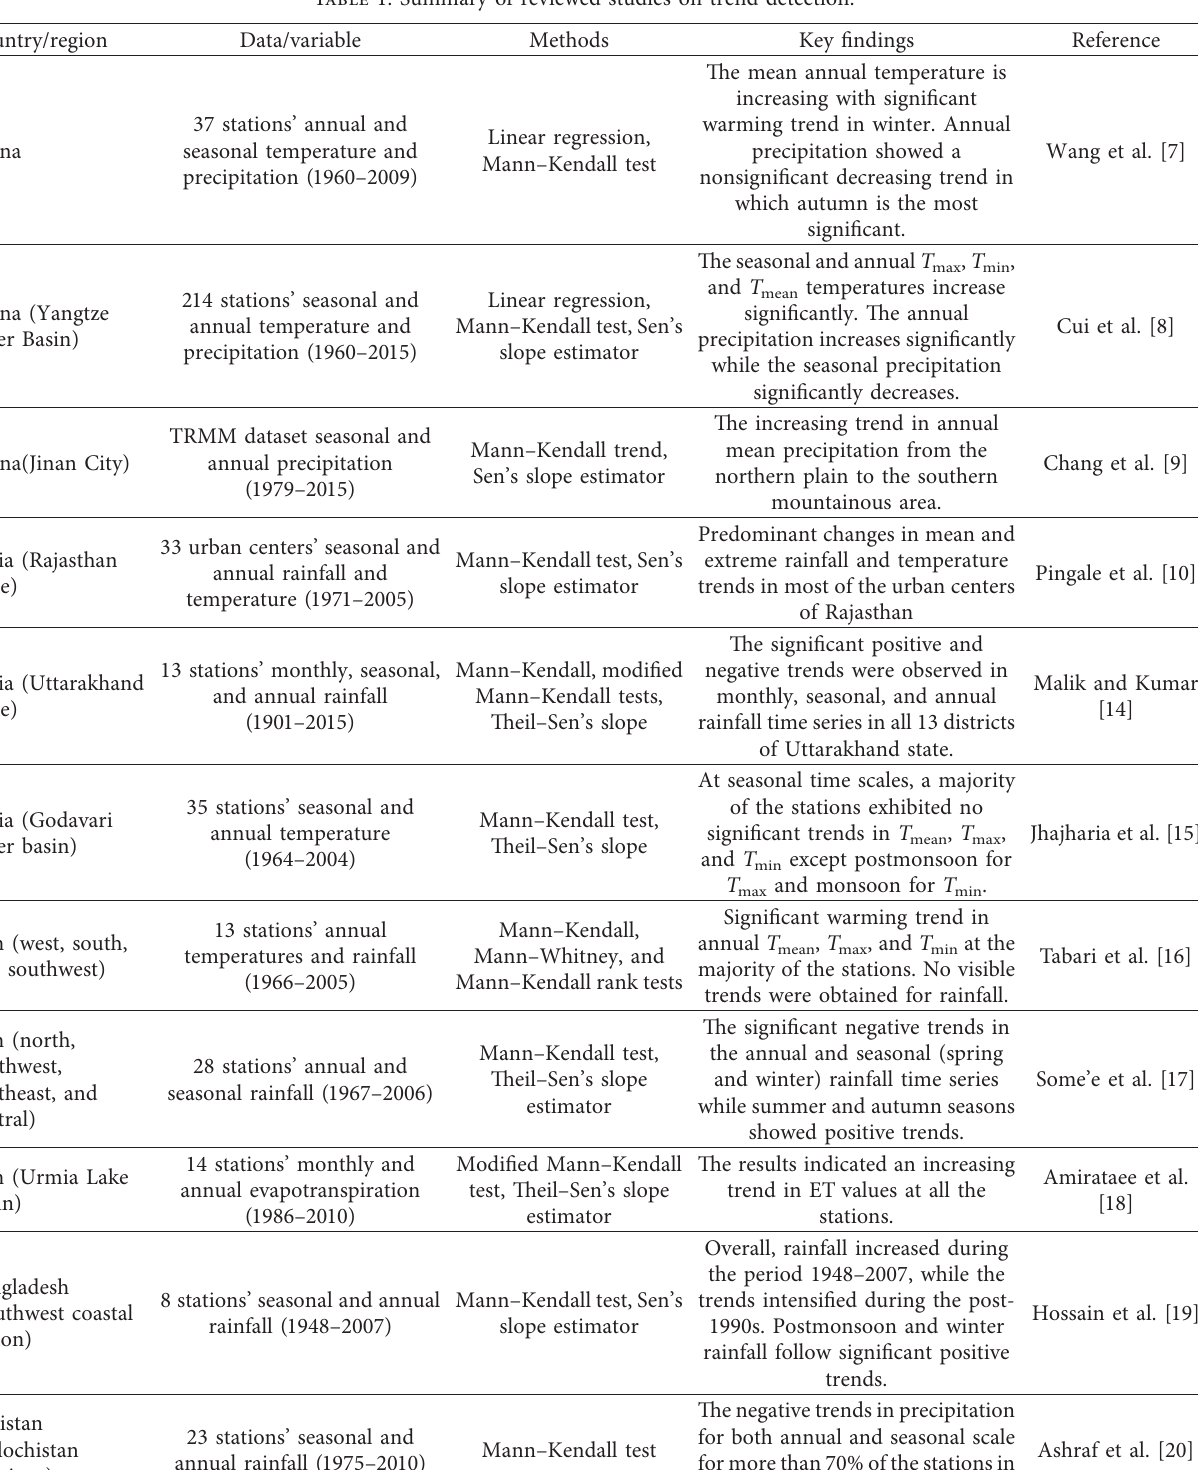
Table 1: Summary of reviewed studies on trend